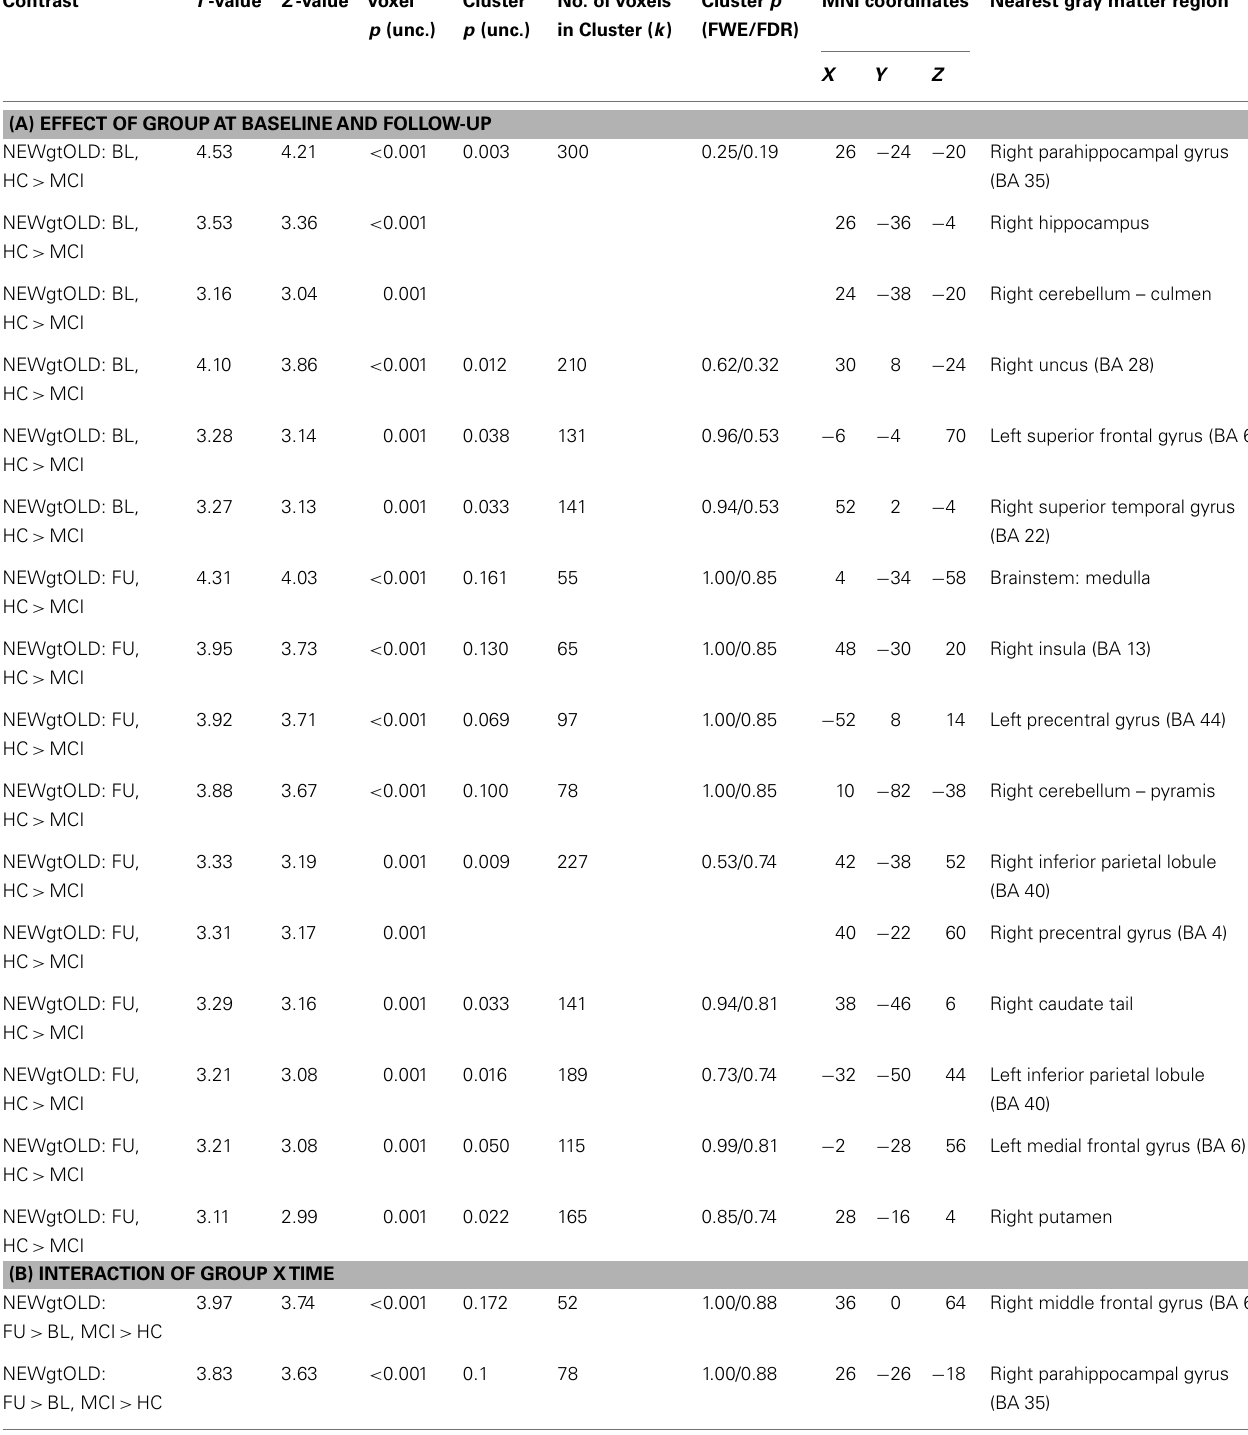
TableA1 | Brain activation during episodic memory encoding task